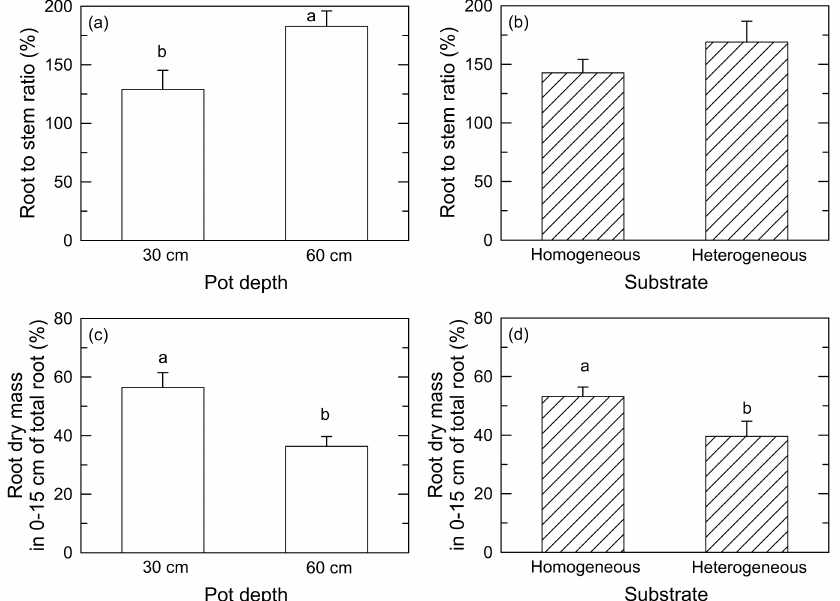
Figure 5. ( a , c ) Root to stem ratio and root dry mass in the first 0–15 cm depth of total root of Populus sibirica seedlings in 30 and 60 cm containers and in ( b , d ) homogenous and heterogeneous substrates. Different lowercase letters indicate significant differences between substrate treatments or container depth treatments. Vertical bars show standard